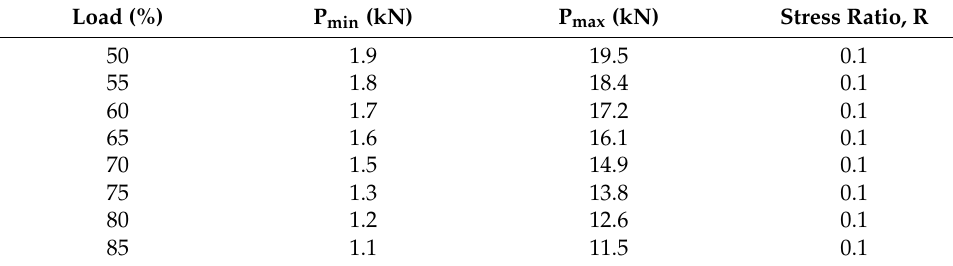
Figure 6. Constant amplitude loading schematic design for the cyclic test.